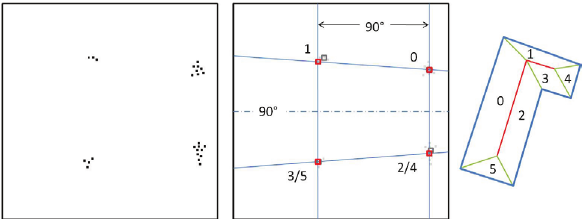
Figure 4. Joint adjustment of plane parameters: the preliminary result of the 3D Hough transform (left), results before (gray) and after (red) joint planes adjustment (middle), and the underlying model (right)